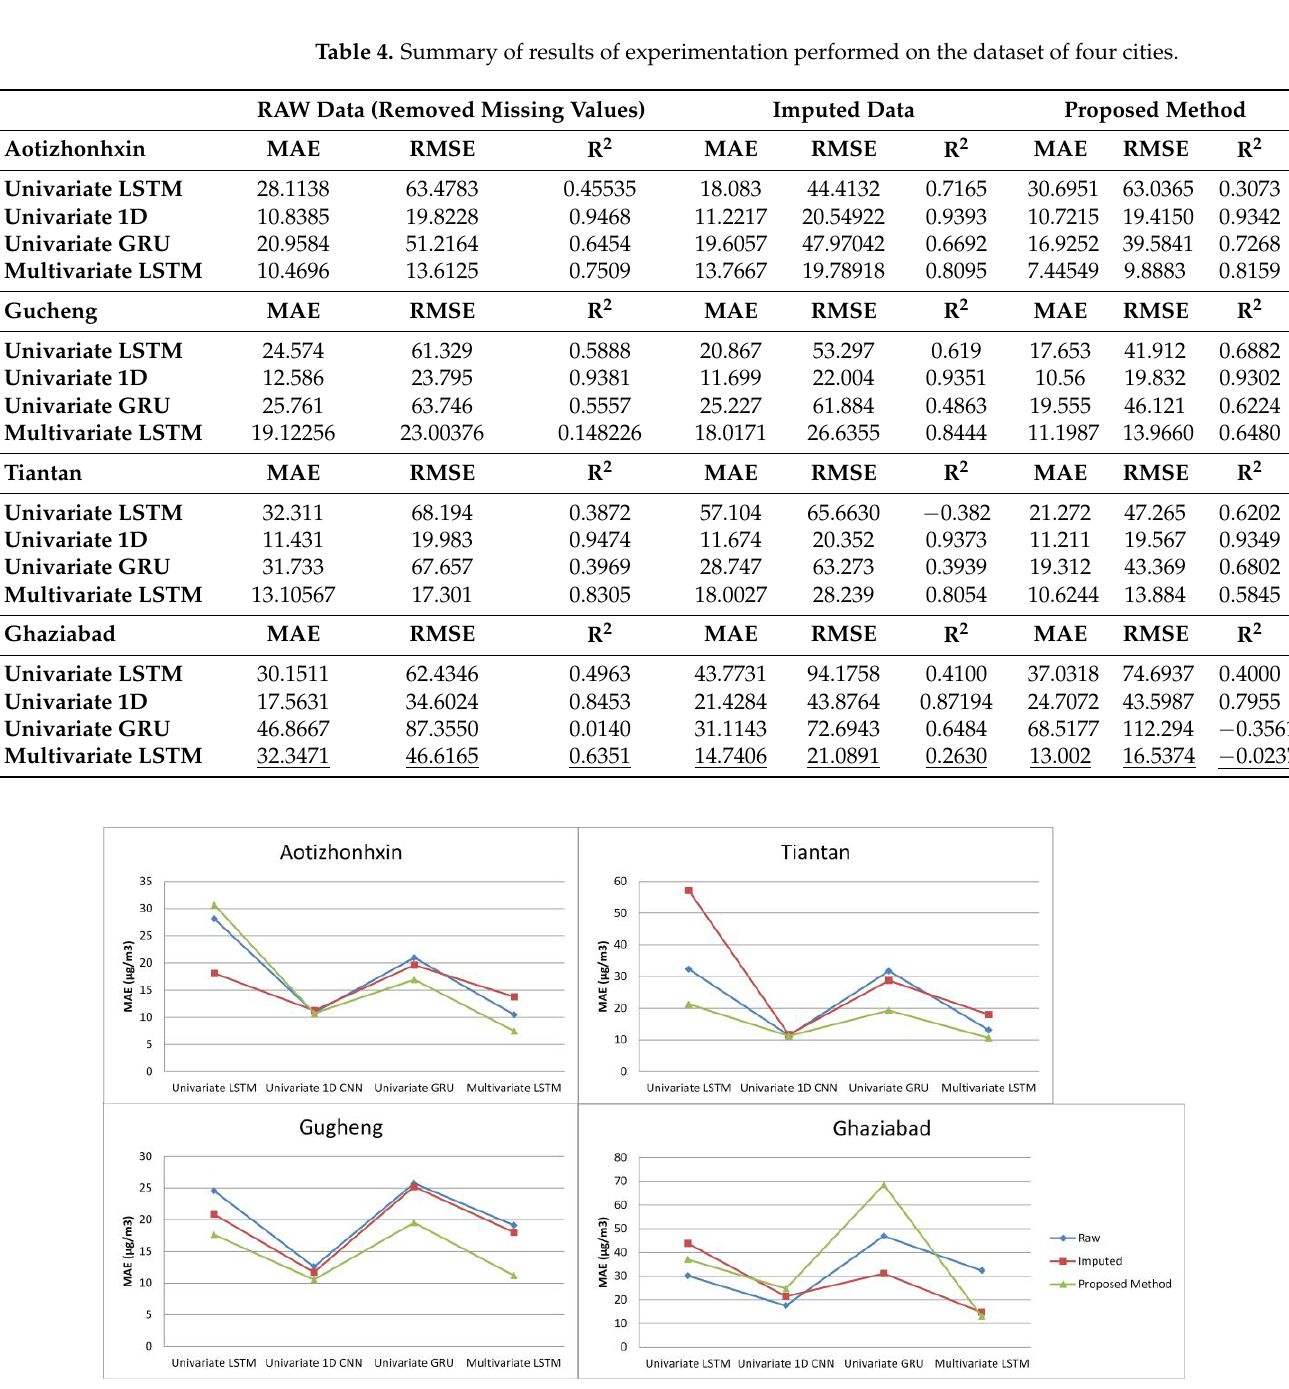
Figure 4. Graphs showing MAE values for all experimentations.